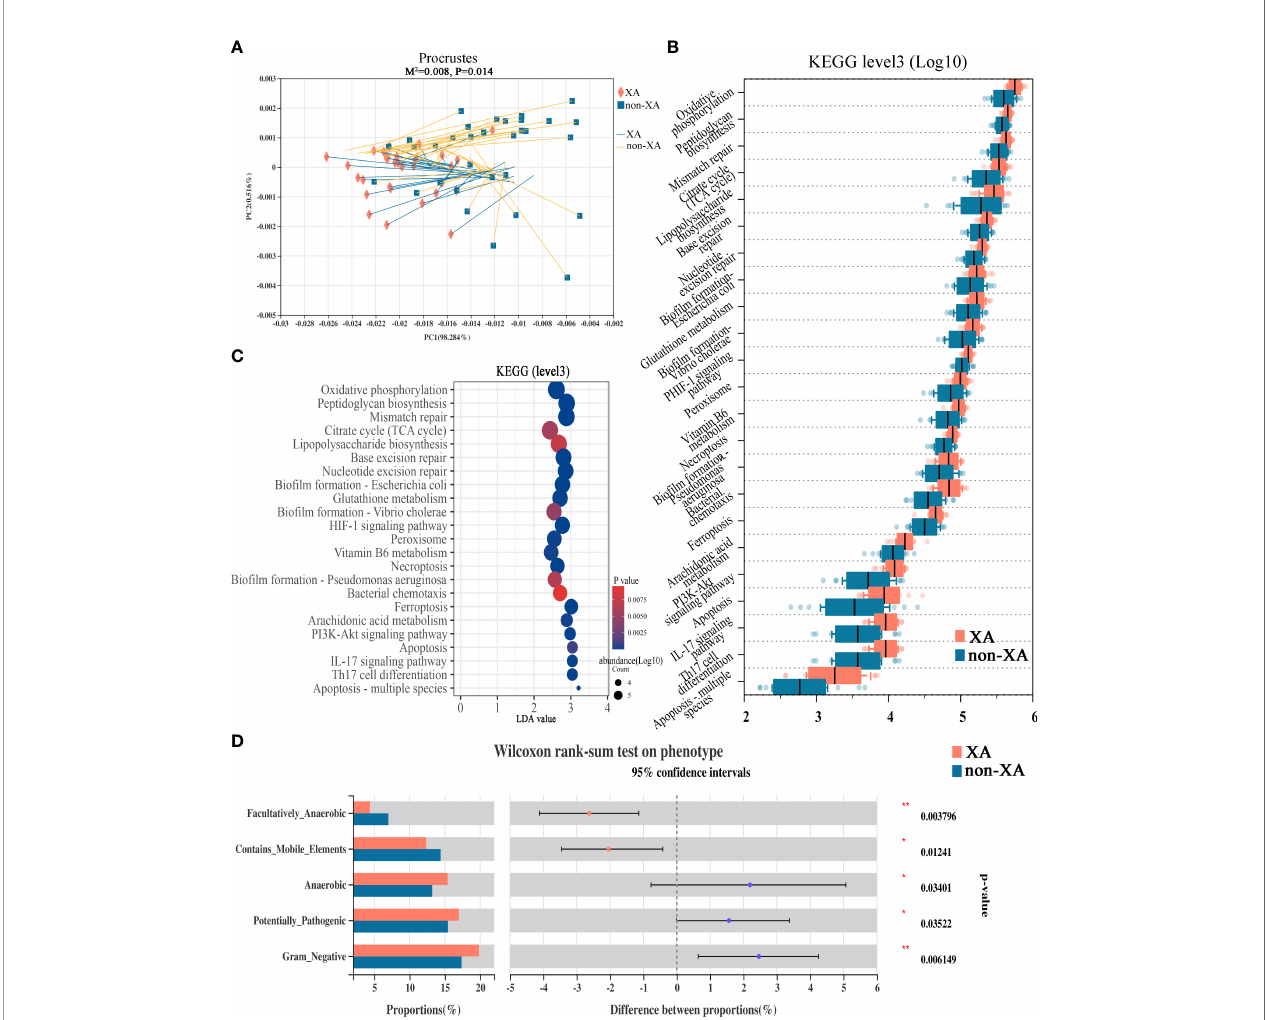
FIGURE 5 | Functional alterations in the oral microbiota among XAs and non-XAs. (A) Procrustes analyses demonstrated a signi fi cant correlation between oral microbial composition and the potential function pro fi le. The solid shape (square and cross) at one end of the line segment represented the sorting result of high- throughput sequencing data, the XA and non-XA groups were colored in orange and blue, respectively; The other end represented the ranking result of metabolic data, M 2 : the goodness-of- fi t statistic of the ranking results in Platts analysis, used to evaluate the correlation between the ranking results, Monte Carlo P-value: indicates the value generated by Monte Carlo simulation P-value, used to test the signi fi cance of M 2 . (B) Twenty-three differential KEGG metabolic pathways were identi fi ed by PICRUSt2 (P < 0.05). (C) The bubble chart displayed 23 differentially abundant KEGG pathways by PICRUSt2. KEGG pathways with LDA values greater than two were retained. (D) BugBase phenotype prediction. XAs, xerostomia patients; non-XAs, patients without xerostomia. KEGG, Kyoto Encyclopedia of Genes and Genomes; LDA, linear discriminant analysis; PICRUSt2, Phylogenetic Investigation of Communities by Reconstruction of Unobserved States 2; * 0.01 < P < 0.05, ** 0.001 < P <